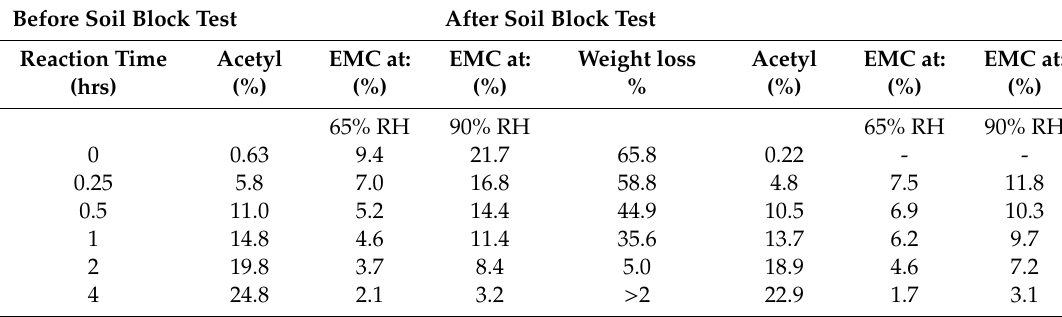
Table 1. Acetyl content of radiata pine reacted with acetic anhydride at various reaction times at 120 ◦ C, equilibrium moisture content (EMC) and weight loss in the 12-week soil block test. Before Soil Block Test